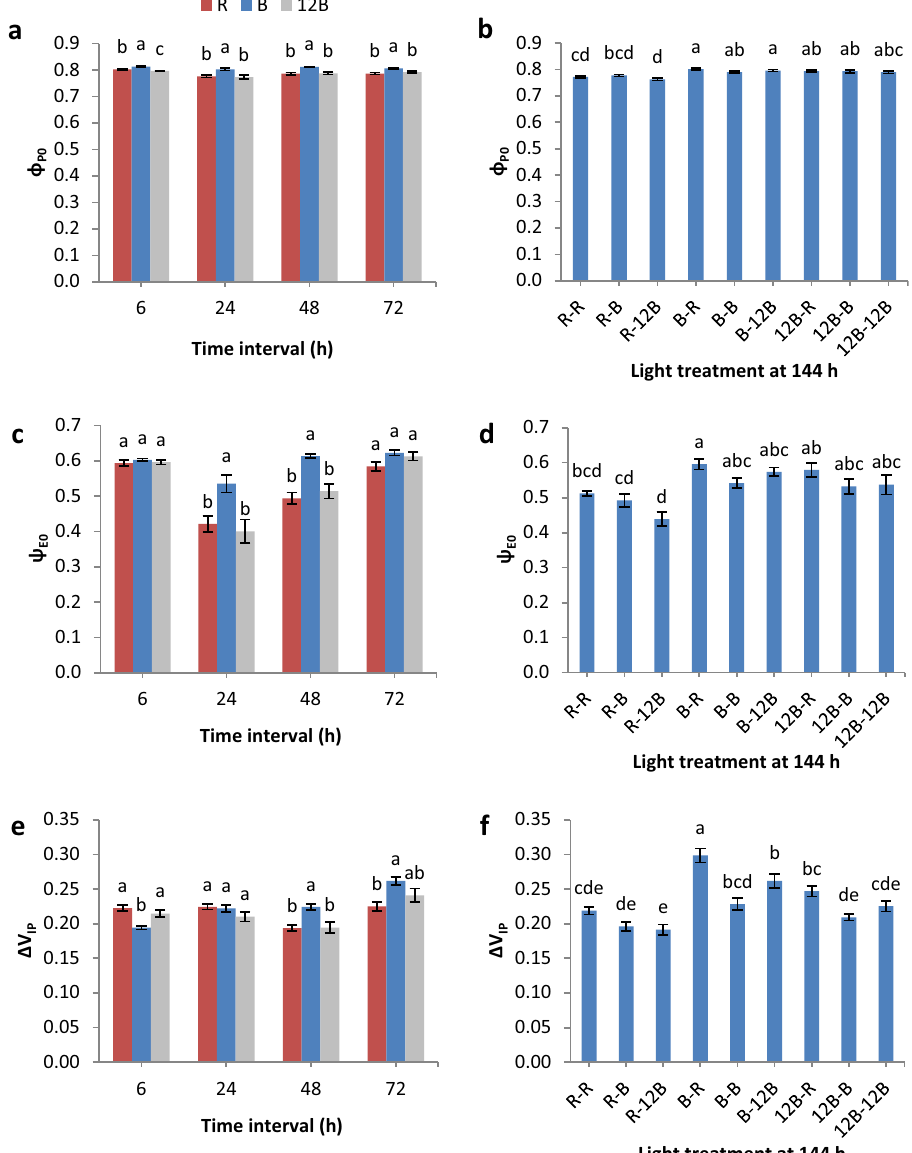
Figure 2. Quantum efficiency of reduction of Q A (φ P0 ) ( a , b ), probability of electron transport beyond Q A– (Ψ E0 ) ( c , d ), and relative fluorescence increase between I- and P-step (ΔV IP ) ( e , f ) of grafted watermelon seedlings at four time intervals under three light treatments ( a , c , e ) and at day 6 (144 h) under nine light treatments ( b , d , f ) in the healing chamber. Bars (± SE) within a time interval followed by different letters are significantly different (a < 0.05). Mean values derived from n = 10